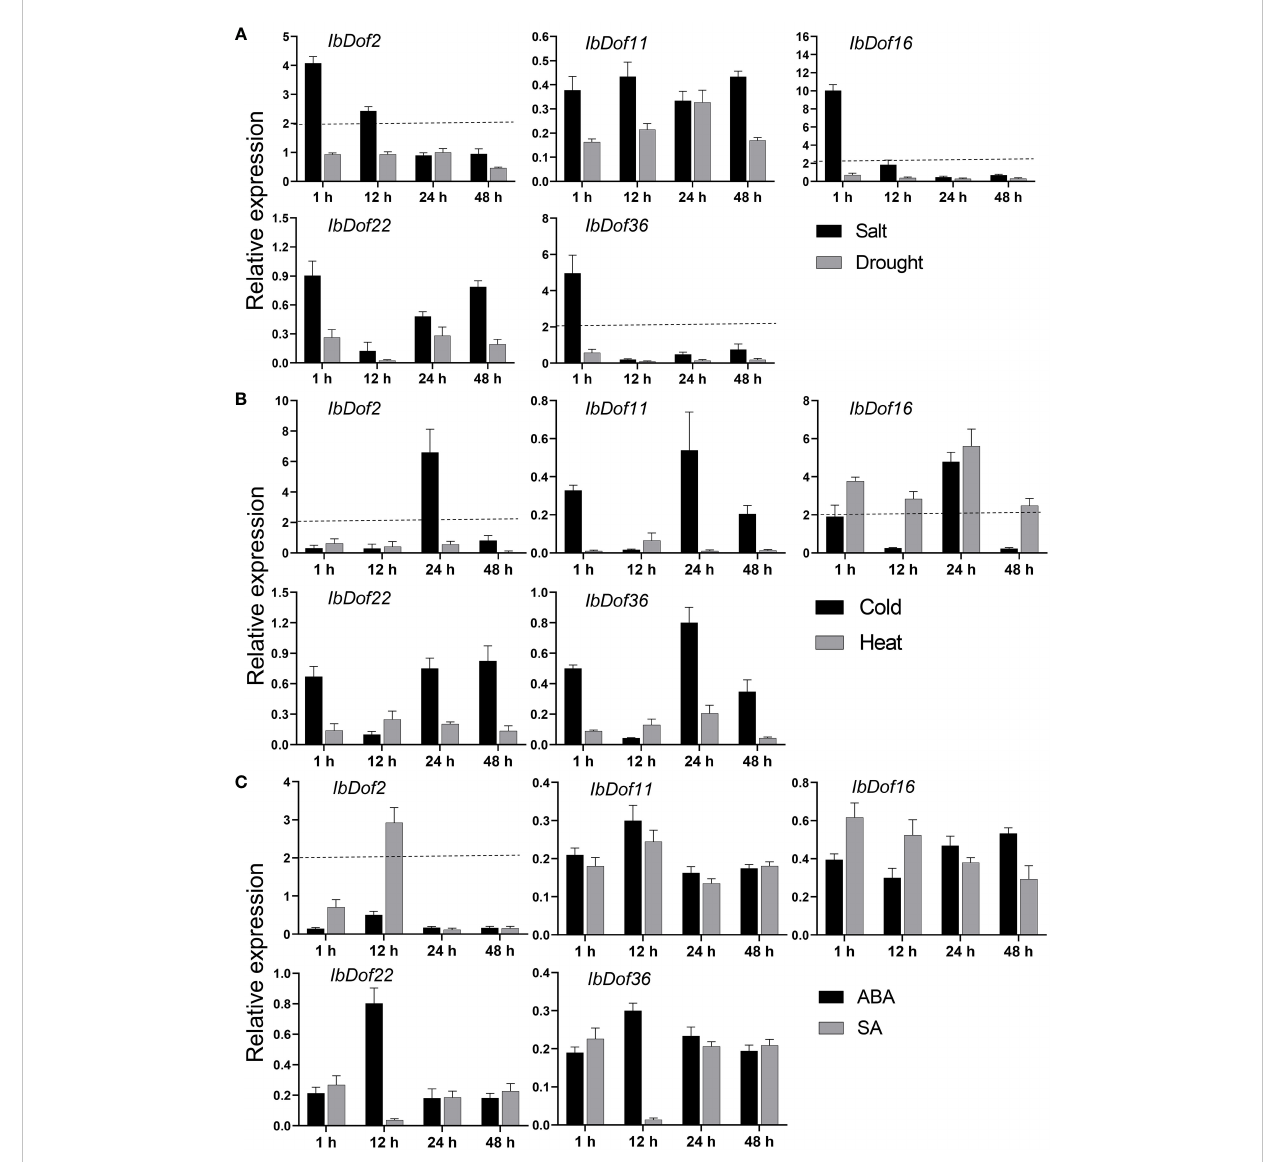
FIGURE 6 Relative expression levels of fi ve IbDof genes in response to abiotic stress and hormone treatments detected by qRT-PCR. The abiotic stress treatments include salt (150 mM NaCl), drought (20% PEG6000) (A) , cold (4°C) and heat (42°C) (B) , and ABA (0.1 mM) and SA (2 mM) (C) . Samples were collected at 1, 12, 24, and 48 h after each treatment, the expression levels at 0 h were normalized to 1, and the Y-axis delineates the fold changes of relative expression comparing with 0 h. Bars represent the mean of three biological replicates ± SE. The two-fold threshold is presented by a dotted